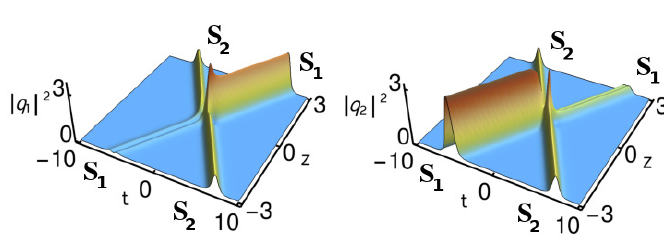
Figure 13. Energy switching collision between CCS and ICS in a 2-CCNLS system